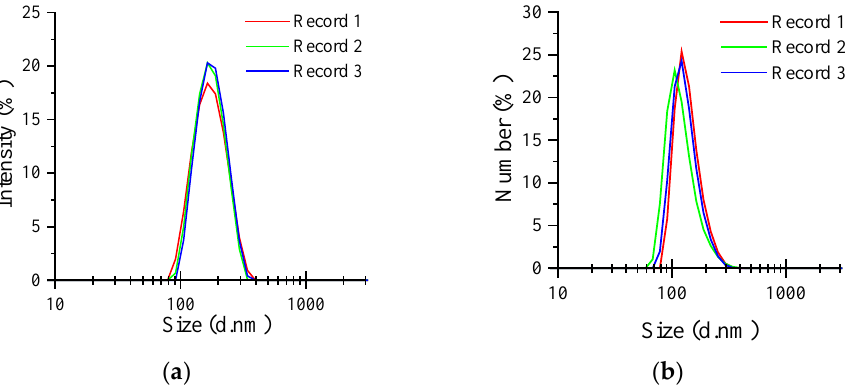
Figure 3. AAP-NP particle size distributions ( a ) intensity; ( b ) number. Records 1 to 3 represent the repeated experiments.